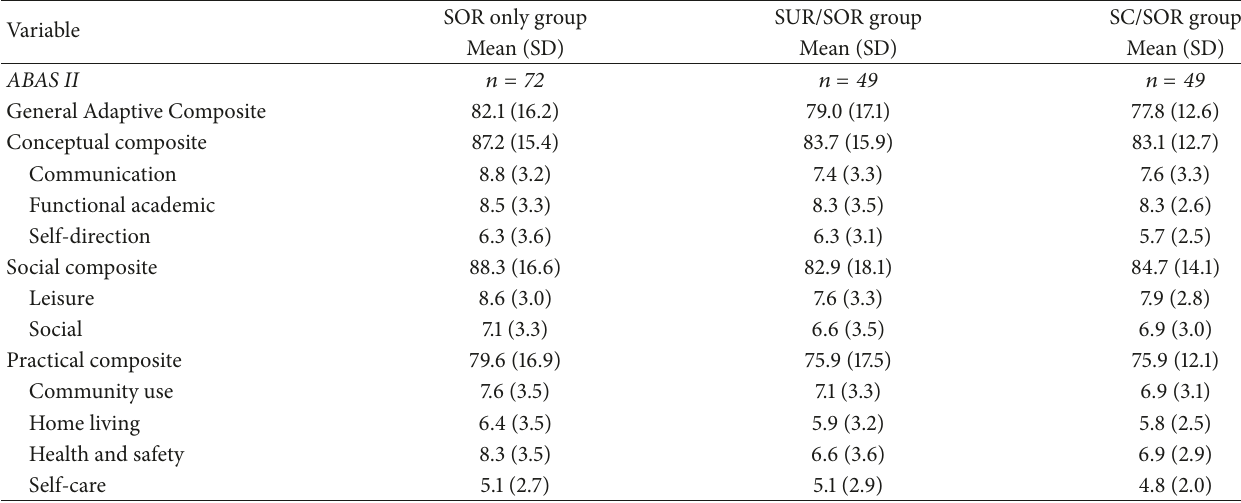
Table 2: Mean scores from the ABAS II by cluster